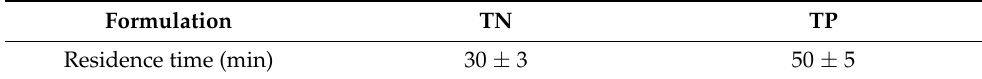
Table 3. The residence time of the